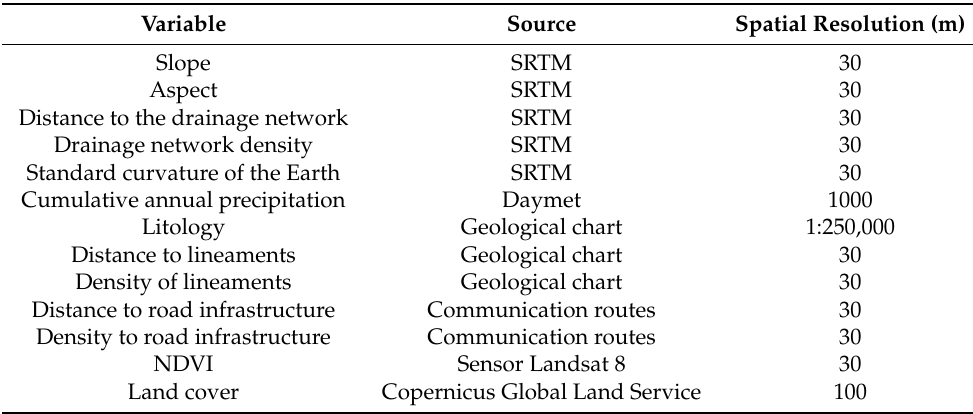
Table 1. Explanatory variables to fit the model of susceptibility